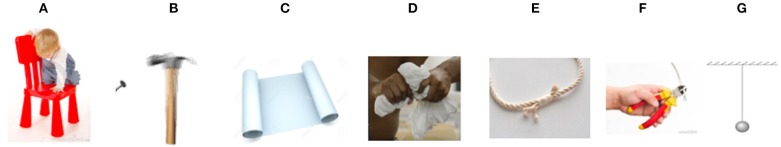
Visual depiction of different representations used to organize or re-represent problem objects when solving two strings problem—from (A) hammering a nail in the wall to (G) pendulum.